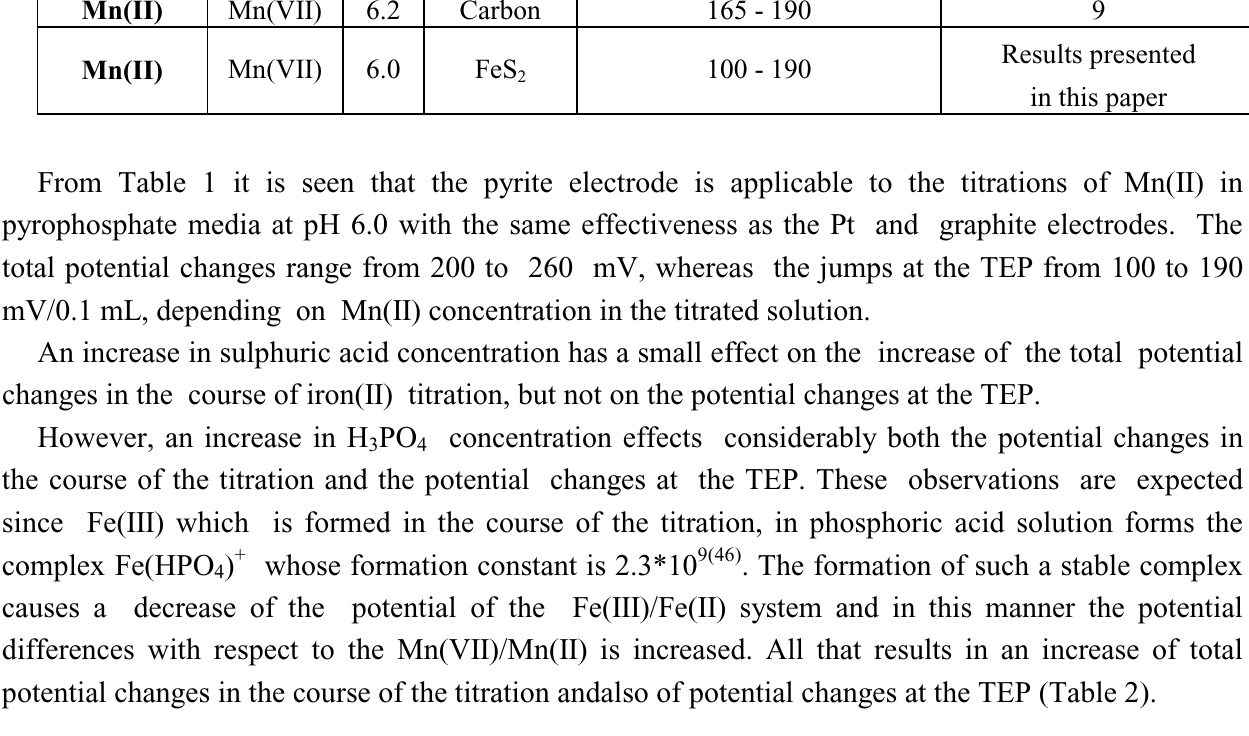
Table 2. Results obtained in potentiometric titrations of reducing substances with standard potassium permanganat solution (electrode couple FeS